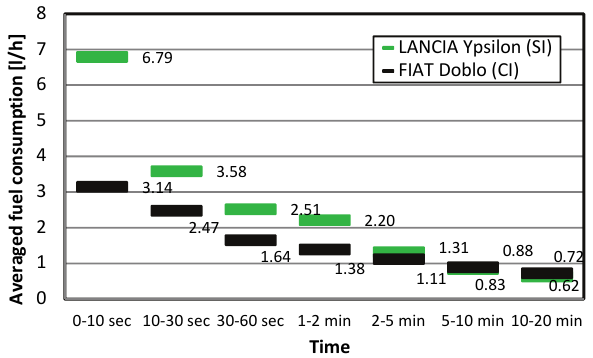
Fig. 6. Averaged fuel consumption at the temperature –18°C